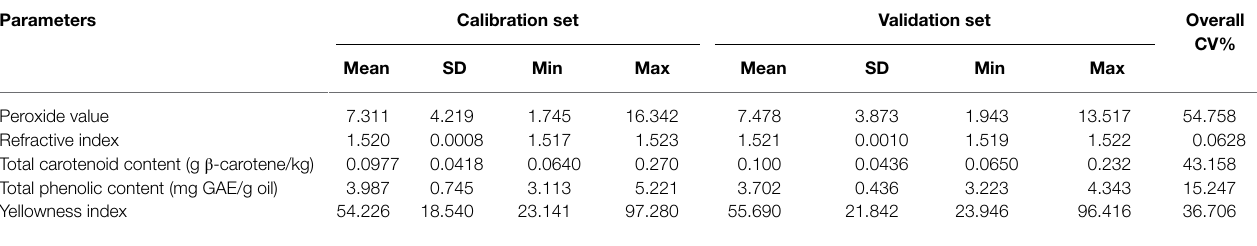
TABLE 1 | Mean, standard deviation (SD), range, and coefficient of variation (CV) for calibration and validation subsets for selected parameters of pomegranate kernel oil (sample number = 42).